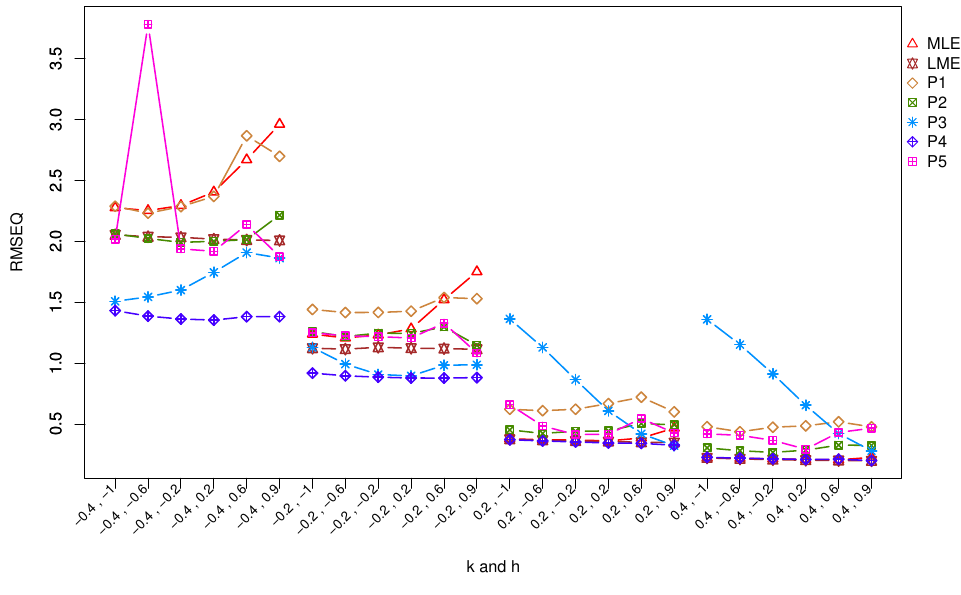
Figure 6. Same as Figure 3, but for the root mean squared error (RMSE) of the estimates of the 95th percentile